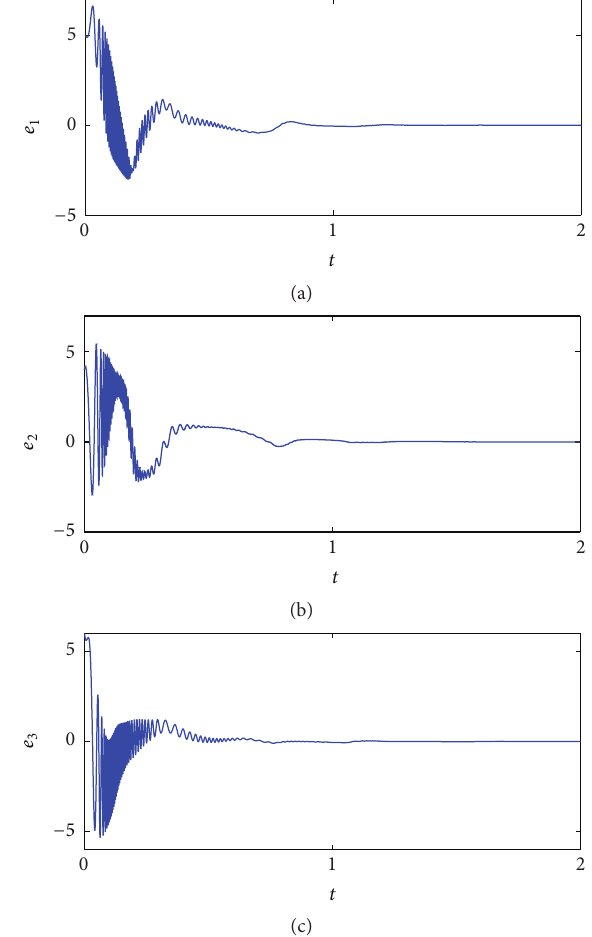
Figure 5: The CGFPS errors between the multidrive systems (19)– (21) and the response system